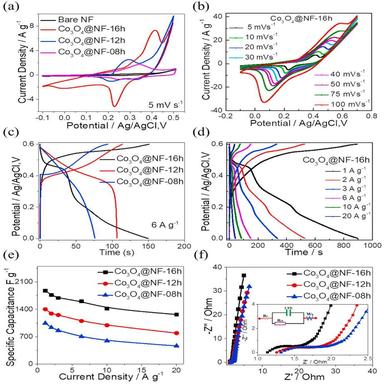
(a) Comparative CV curves of bare-NF and different Co3O4@NF electrodes, (b) CV curves of Co3O4@NF-16h electrode, (c) Comparative GCD curves of Co3O4@NF electrodes, (d) GCD curves of Co3O4@NF-16h electrode, (e) Specific capacitance of Co3O4@NF electrodes, (f) EIS spectrums of Co3O4@NF electrodes with electrical circuit.